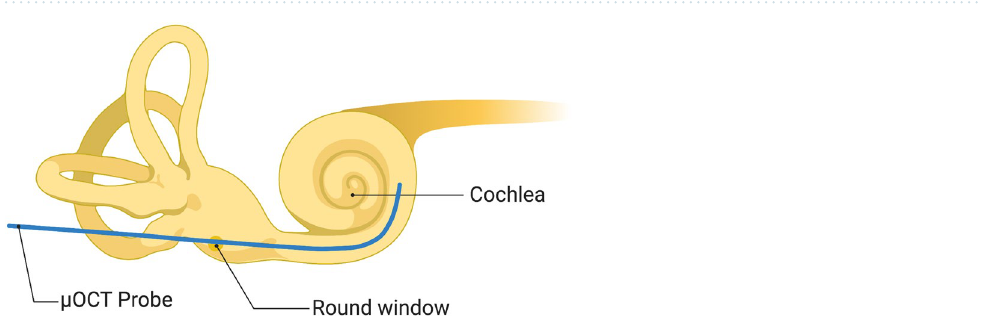
Figure 4. Schematic of the µOCT probe insertion into the cochlea through the round window. Created with www. BioRe nder.